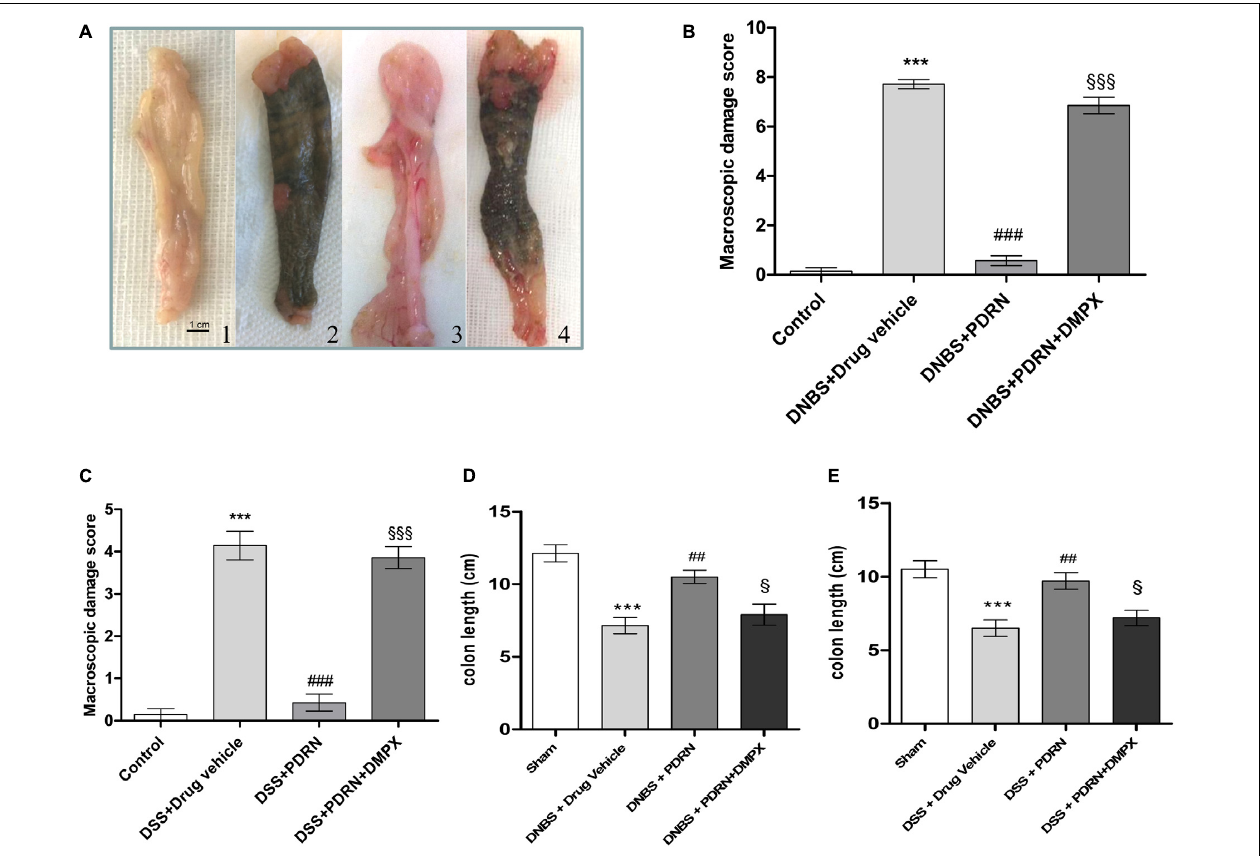
FIGURE 2 | Macroscopic evaluations. Colons (A) from control (1) , DNBS + drug vehicle (2) , DNBS + PDRN (3) , DNBS + PDRN + DMPX (4) are depicted. Macroscopic damage scores from the DNBS model and the DSS model are summarized in (B) and (C) , respectively, while colon length is shown in (D) and (E) for these models. Values were obtained from seven animals per group, and are expressed as the means and SEM. ∗∗∗ p < 0.0001 vs control group; ## p < 0.001, ### p < 0.0001 vs DNBS/DSS + drug vehicle group; § p < 0.01, §§§ p < 0.0001 vs DNBS/DSS + PDRN